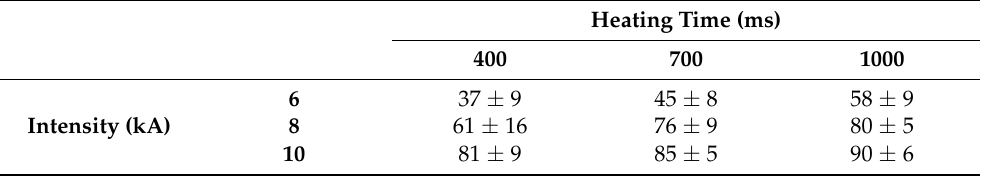
Table 3. Values of microhardness (HV1) for the different MF-ERS compacts. The mean values and standard deviations have been computed from each specimen with the values measured in the five points indicated in Figure 4. The final results are the mean values from the four studied compacts obtained under identical conditions.